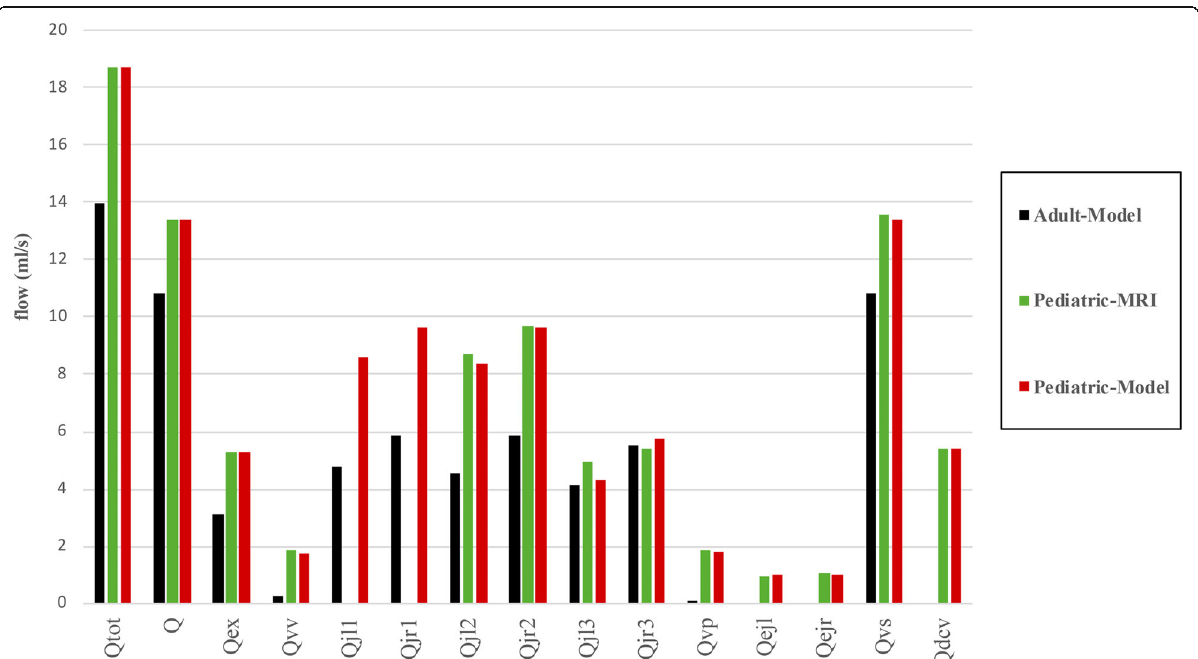
Fig. 5 Comparison of simulated paediatric and adult flow rates, and paediatric experimental data. Q Cerebral blood flow, dcv Deep cervical vein, jl1 Lower segment of the left jugular vein, jl2 Middle ejl Left external jugular vein, ejr Right external jugular vein, Q ex Extracerebral blood flow, segment of the left jugular vein, jl3 Upper segment of the left jugular vein, jr1 Lower segment of the right jugular vein, jr2 Middle segment of the right jugular vein, jr3 Upper segment of the right jugular vein, Q tot Blood flow to the head, vp Venous plexus, vs Venous sinus, vv Vertebral